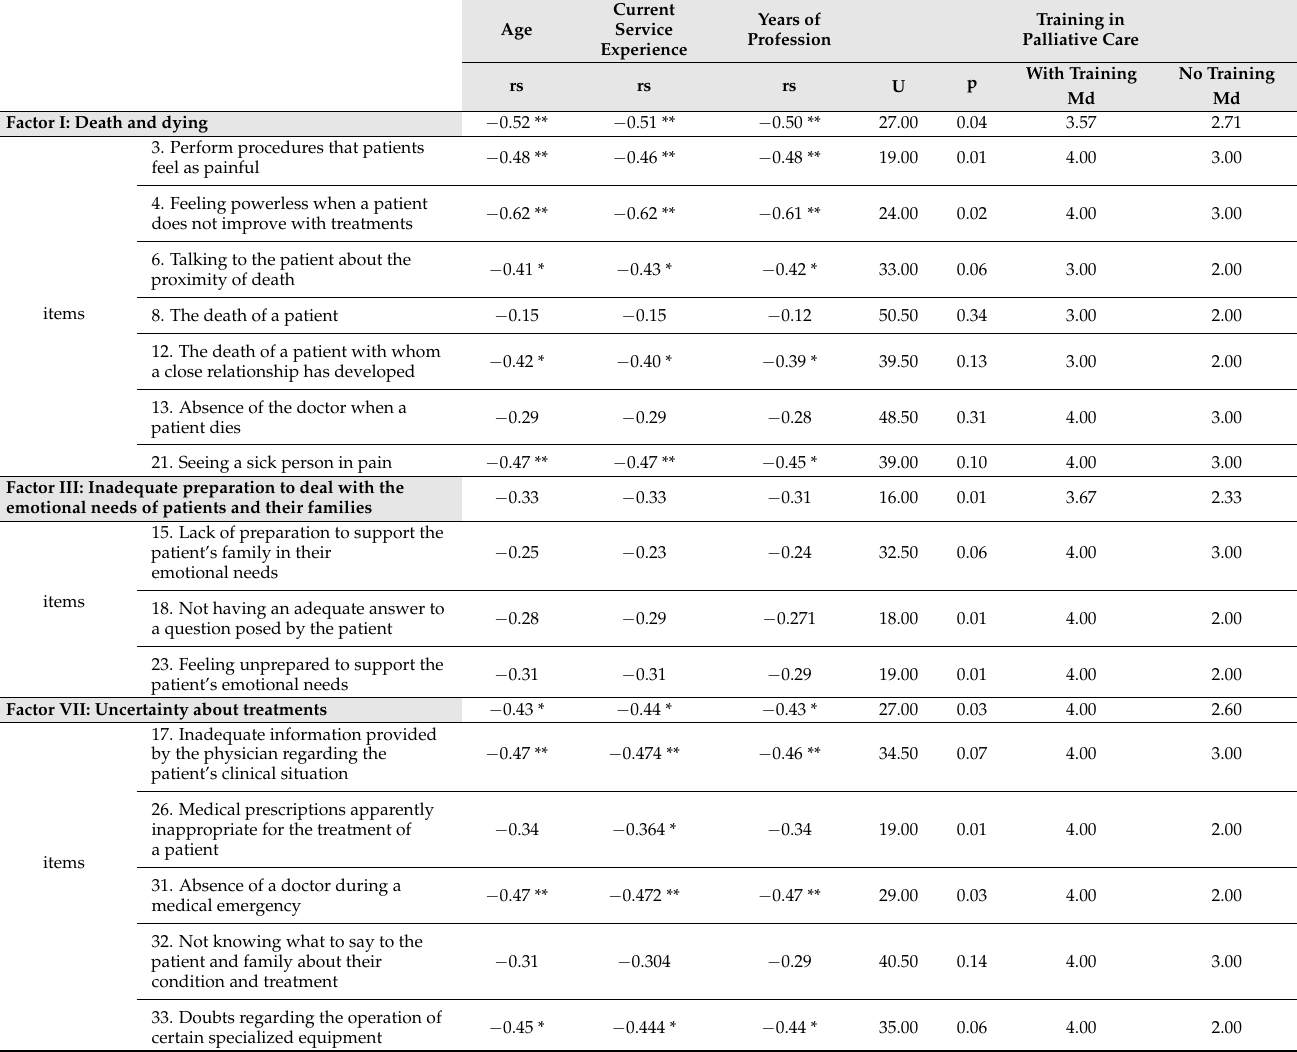
Table 2. Statistical analysis between intrapersonal domain and demographic and professional